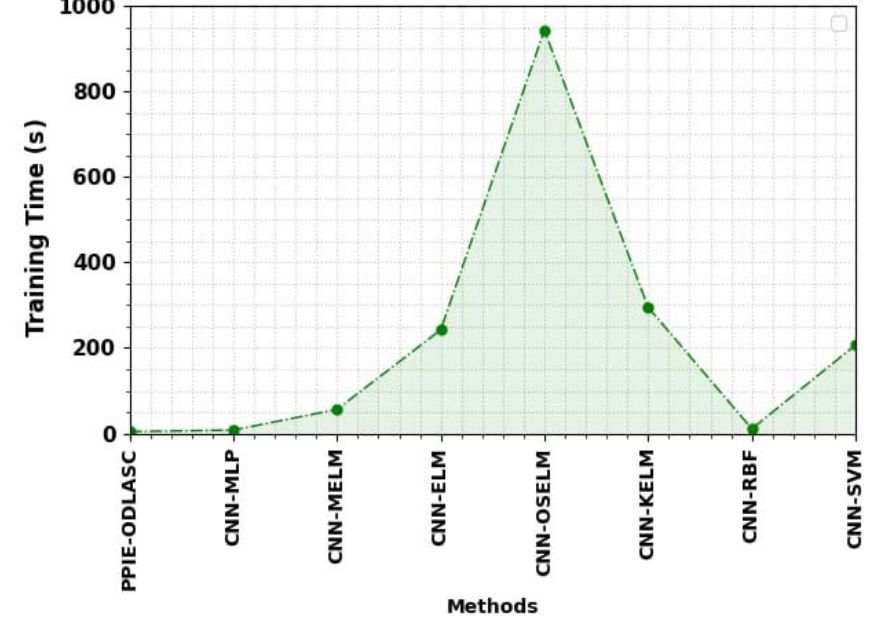
Figure 14. TRT analysis of the PPIE-ODLASC approach with other recent systems.